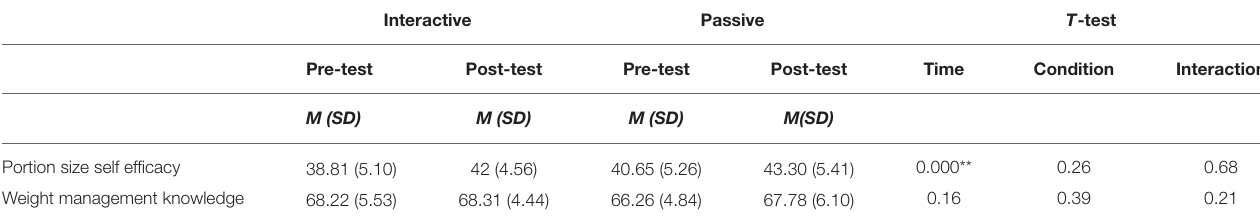
TABLE 2 | Repeated measure ANOVAs on learning outcome measures.